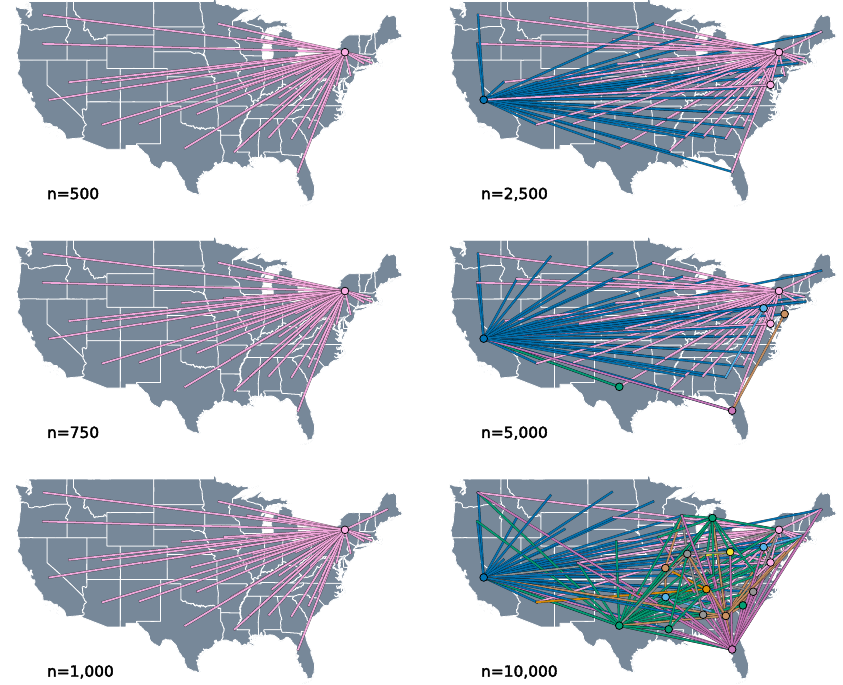
Figure 2. Connectivity plots for the randomly subsampled datasets. The geographical reconstructions from each MCC tree are projected into geographical space by drawing a line for each transition event, connecting origin (circle), and destination. The connectivity plot for the 250 taxa tree is not included in this plot because it was found to be similar to those of the 500, 750, and 1000 taxa datasets. For the connectivity plots for the datasets subsampled using the Phylogenetic Diversity Analyzer, we refer to the Supplementary Materials (Figure S3).